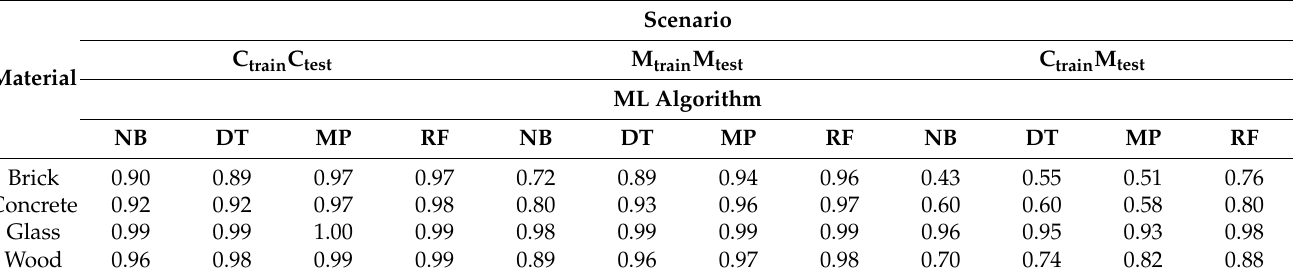
Table 5. F-score per material with different ML